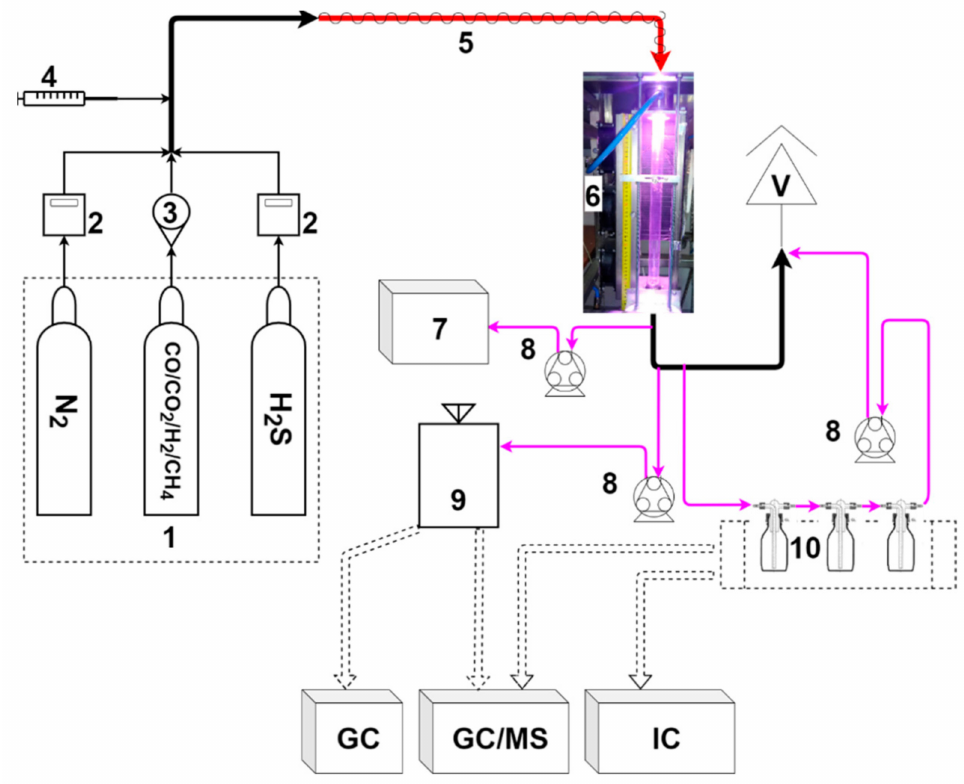
Figure 1. Experimental setup: 1—gas cylinders; 2—mass flow controller; 3—rotameter; 4—syringe